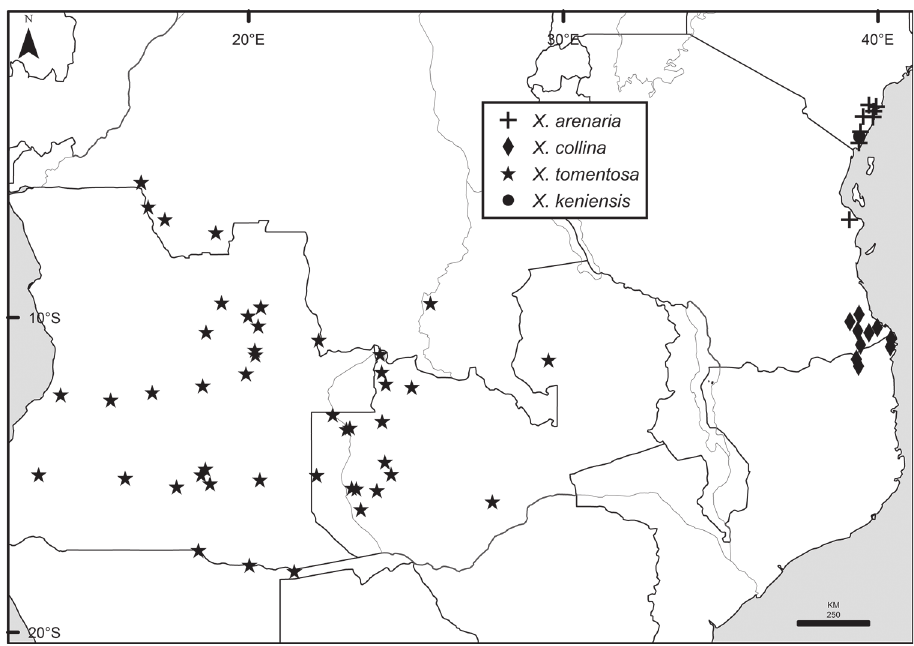
Figure 22. Distributions of Xylopia arenaria , X. collina , X. tomentosa , and X. keniensis in southern and eastern Africa. Bolder lines represent country borders, fainter lines lakes and major